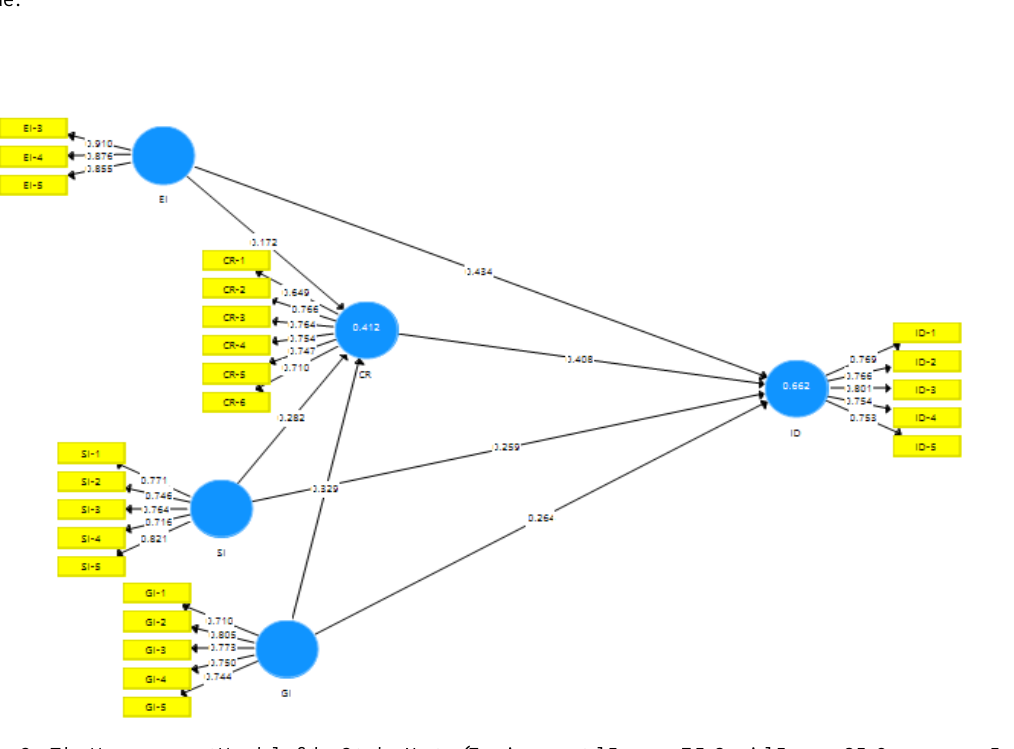
Figure 2: The Measurement Model of the Study; Note: (Environmental Issues= EI; Social Issues=SI; Governance Issues=GI; Corporate Reputation=CR; Investment